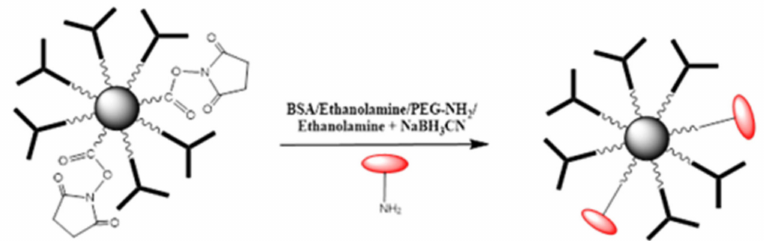
Figure 9. Deactivation of remaining R-CO-NHS groups using BSA / Ethanolamine / PEG-NH 2 / Ethanolamine + NaBH 3 CN.